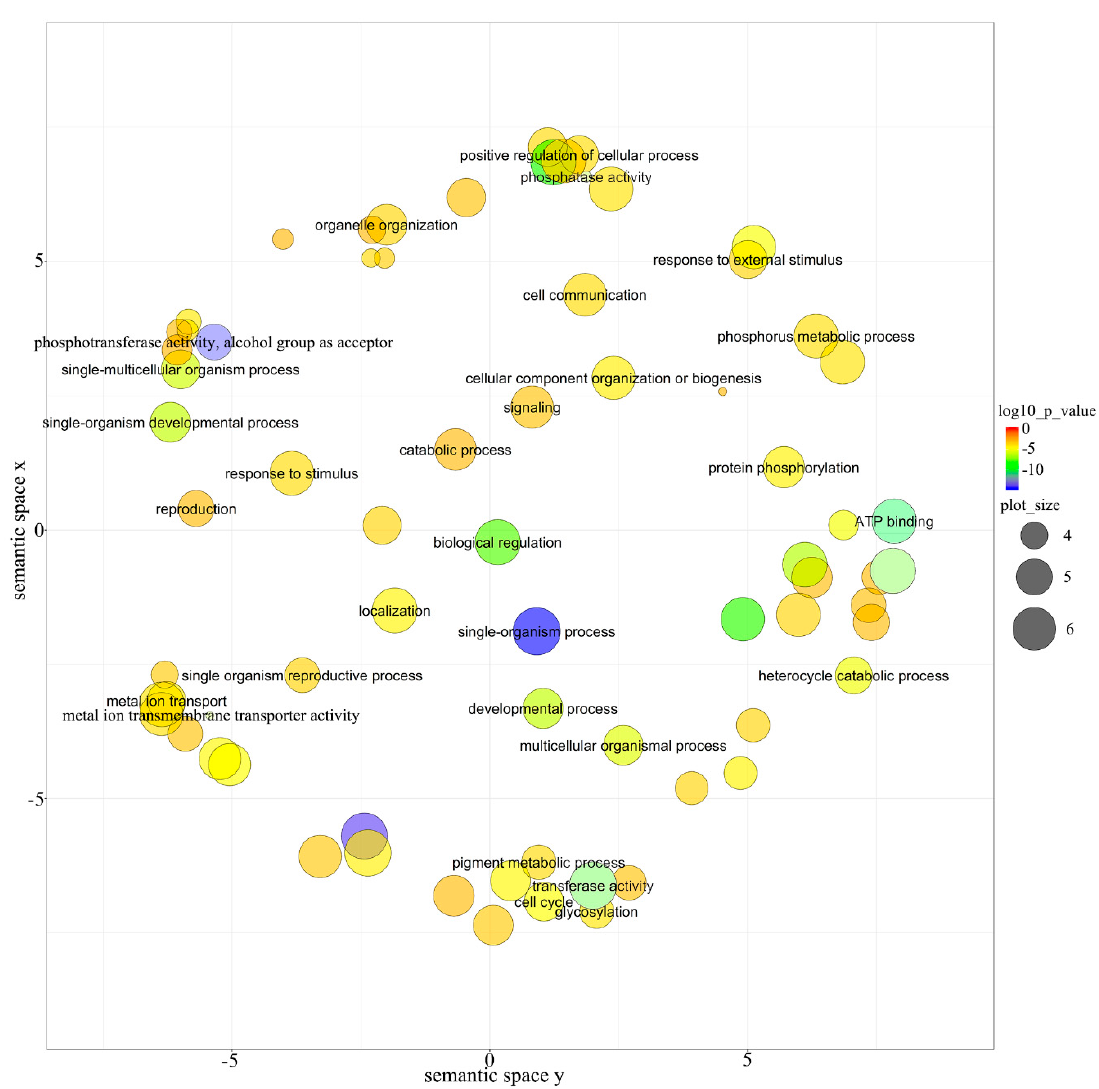
Figure 6. Gene ontology (GO) enrichment analysis of predicted target genes. The color indicates the p -values; size indicates the frequency of the GO term in the GOA database. The bubbles’ x and y coordinates were derived by applying multidimensional scaling to a matrix of the GO terms’ semantic similarities; consequently, their closeness on the plot should closely reflect their closeness in the GO graph structure, i.e., the semantic similarity.